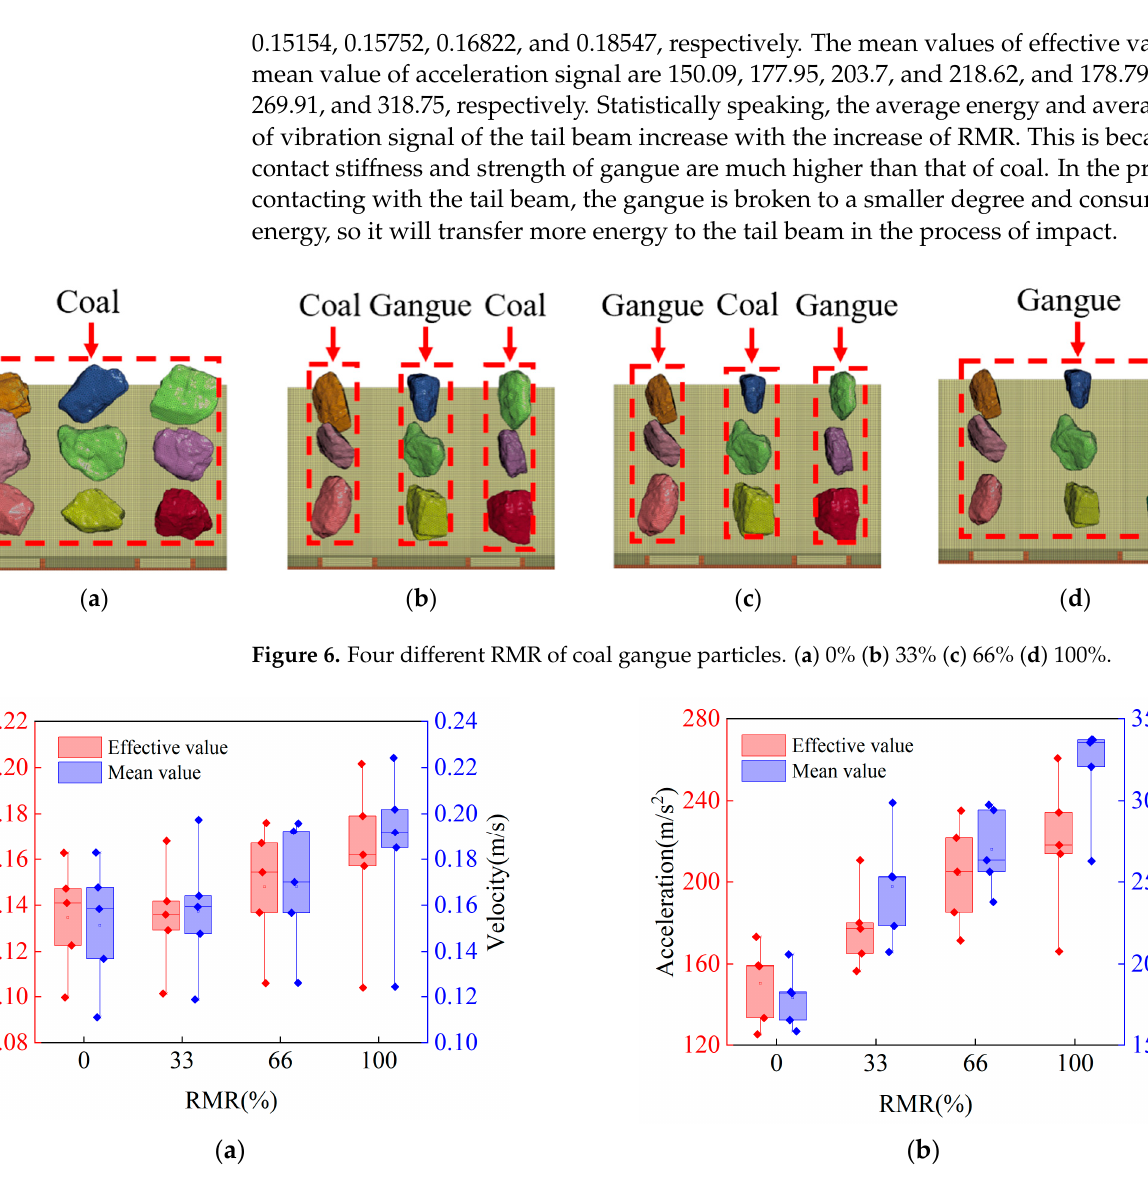
Figure 7. ( a ) Box chart of velocity response in different RMR. ( b ) Box chart of acceleration response in different RMR.